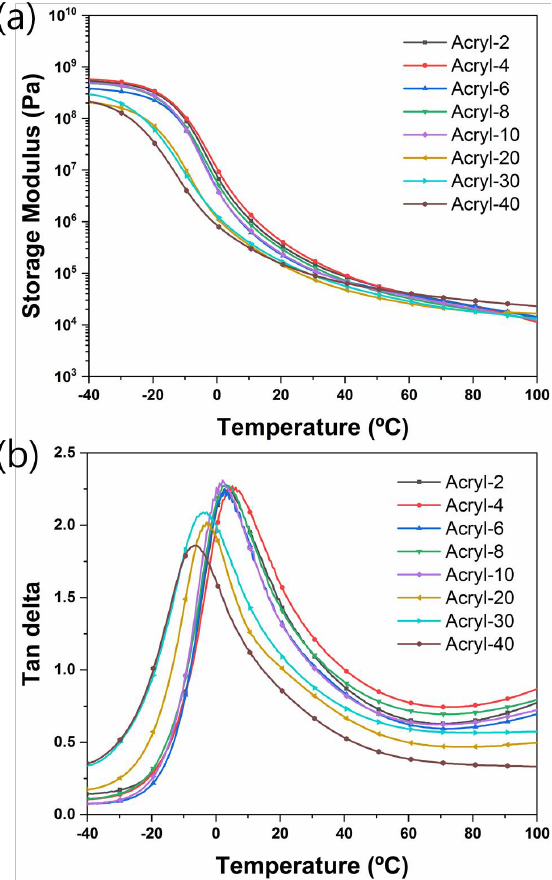
Figure 6. Modulus properties of acrylic PSA films: ( a ) storage modulus (G’); and ( b ) tan δ.